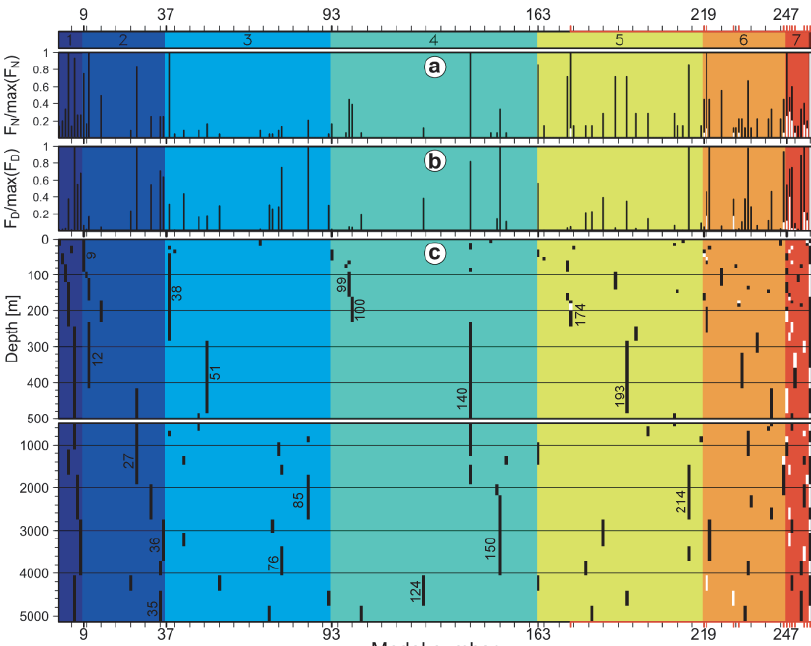
Fig. 2. Summary of the best fitting linear models for the July 1995 GLODAP synoptic synthetic dataset. Background colors identify models size classes (1 to 8). (a) Relative frequency ( F N /max(F N )) with which models are selected in each size class (minimum root-mean-square error, black bars) and overall (minimum AIC, white bars). Frequency is computed based on the number of model layers ( F N ) normalized to the most frequently identified model (max( F N )). (b) Same as (a) but for frequency weighted by the thickness of each layer ( F D /max(F D )). (c) Models with with lowest AIC in each size class (black bars) and overall (white bars, red ticks on top and bottom x-axes) and each depth layer. Tick marks on the right show boundaries between model layers. Tick marks on top and bottom show model number (in steps of 5). The first model number of each size class is indicated, except for size classes 1 and 8 (number 1 and 255).